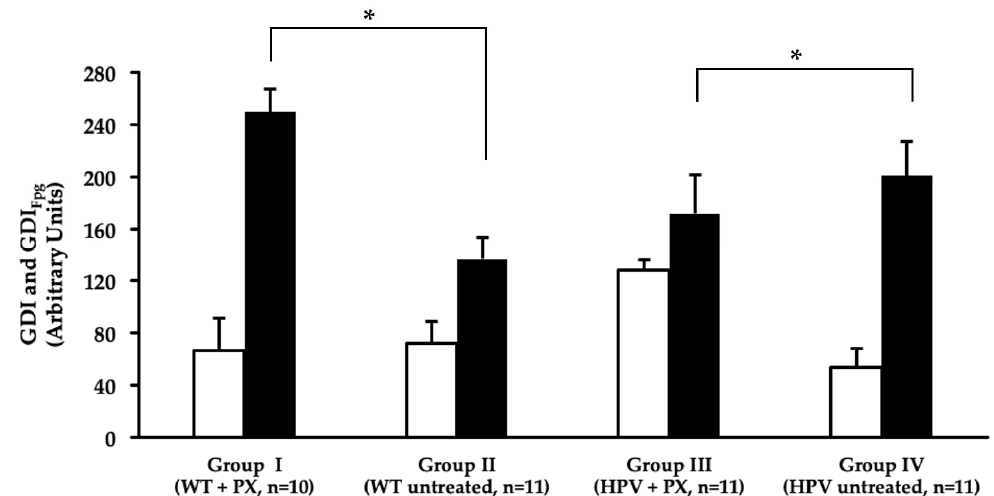
Figure 6. Mean values of genetic damage index (GDI), measured by the alkaline comet assay, in the liver (average ± standard deviation). Treatment without Fpg treatment (GDI) represented in white and treatment with Fpg (GDI Fpg ) are shown in black. HPV—human papillomavirus; PX—parecoxib; WT—wild-type. a —Statistically significant di ff erences in GDI Fpg versus group II ( p < 0.05). b —statistically significant di ff erences in GDI versus group IV ( p < +